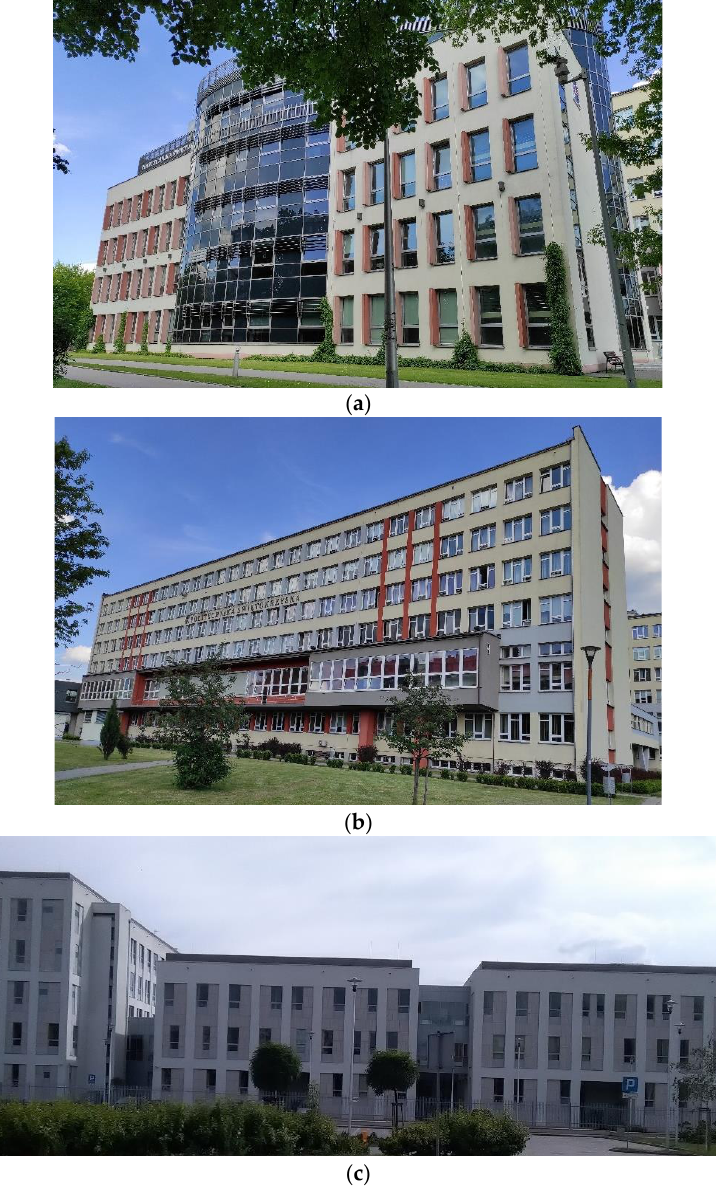
Figure 1. Photographs of “ Energis ” ( a ), building “A” ( b ) and Courthouse ( c ).